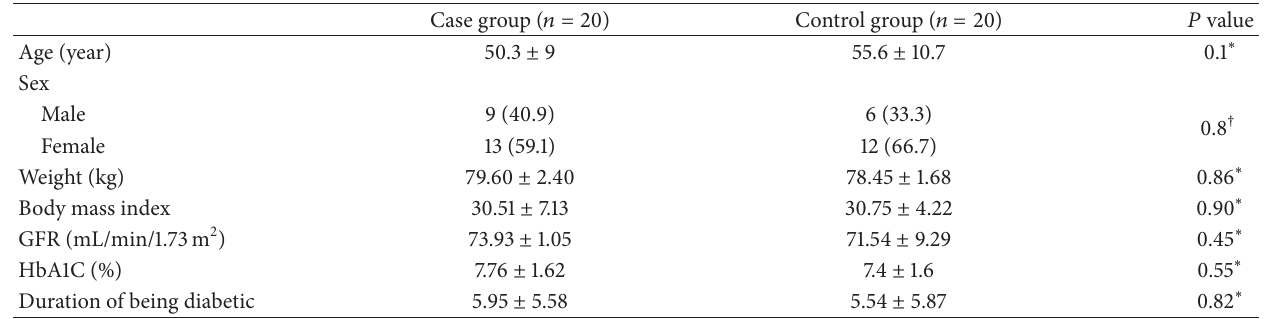
Table 1: Baseline characteristics in 40 studies patients by